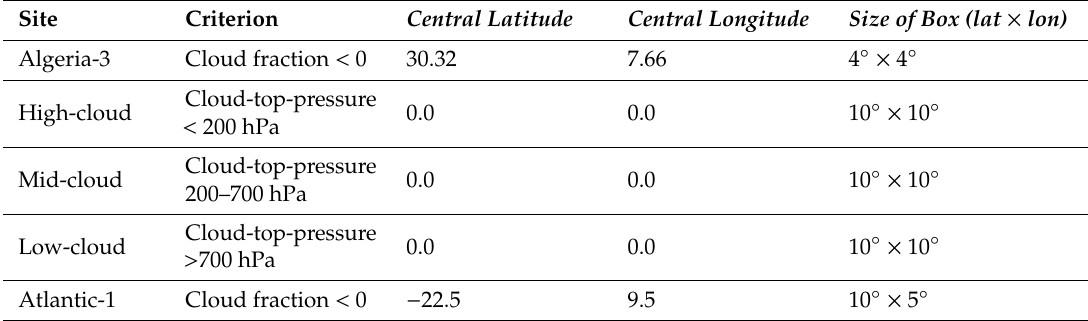
Table 6. Characterisation of the sites used for the comparison of the SEVIRI HRVIS dataset with the operational MVIRI dataset and the harmonised MVIRI FCDR. The sites and criteria are used for the extraction of suited SCIAMACHY spectra for the homogenisation and for the extraction of SEVIRI / MVIRI